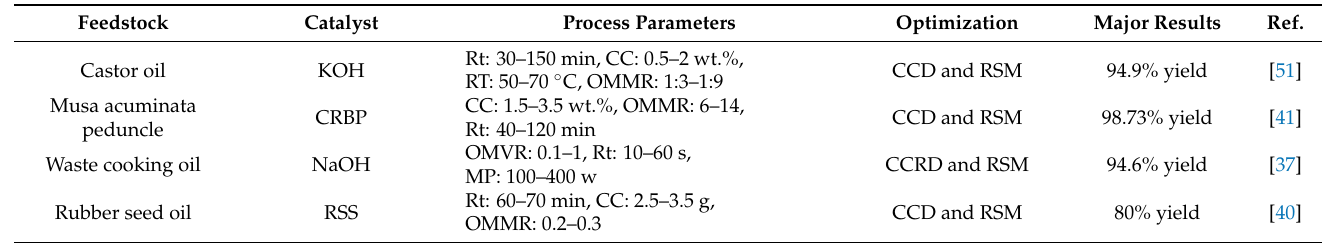
Table 1. Biodiesel production via transesterification process utilizing various feedstocks. Catalyst Process Parameters Optimization Major Results